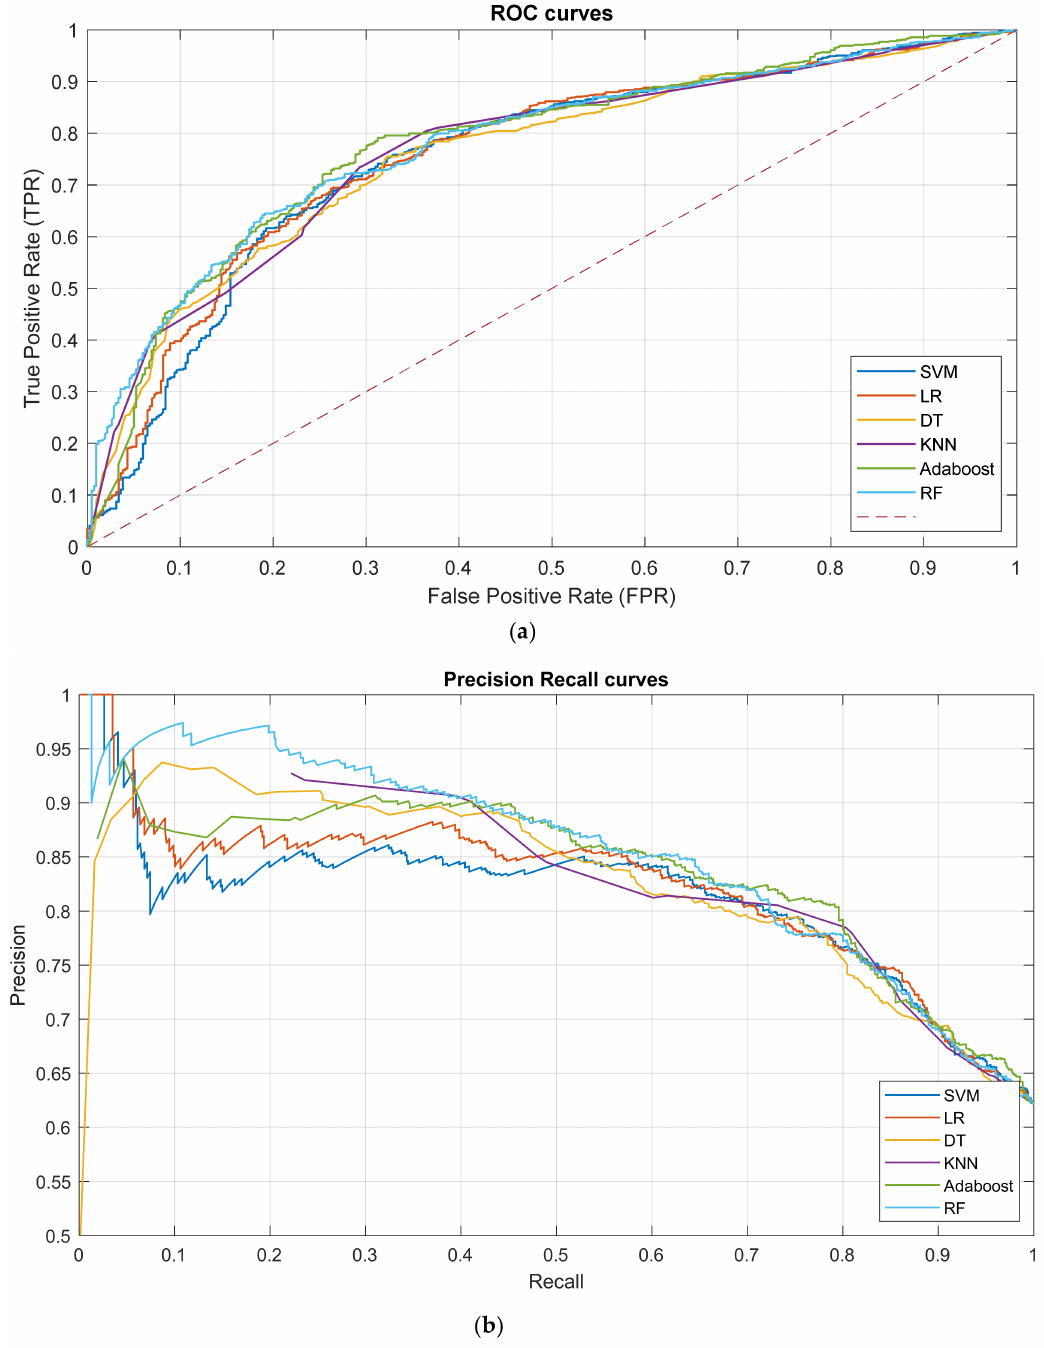
Figure 3. ( a ) Receiver–operating characteristic curves, ( b ) Precision–recall curves for ML models. Figure 4 shows reliability graphs for each of the six competing ML models that compare how well the predicted outputs of the binary classifiers are calibrated. The average predicted probabilities for binned predictions are shown in the X axis, whereas Y axis denotes the proportion of samples whose class is positive per bin. Being a measure of uncertainty, the reliability graphs of Figure 4 demonstrate how closely the predicted class probability reflects its ground truth likelihood. The two ensemble algorithms (Adaboost and RF) were proved to be the most reliable ones achieving the lowest observed mean average errors (MAE of 0.0797 and 0.0692, respectively) from the ideal calibration